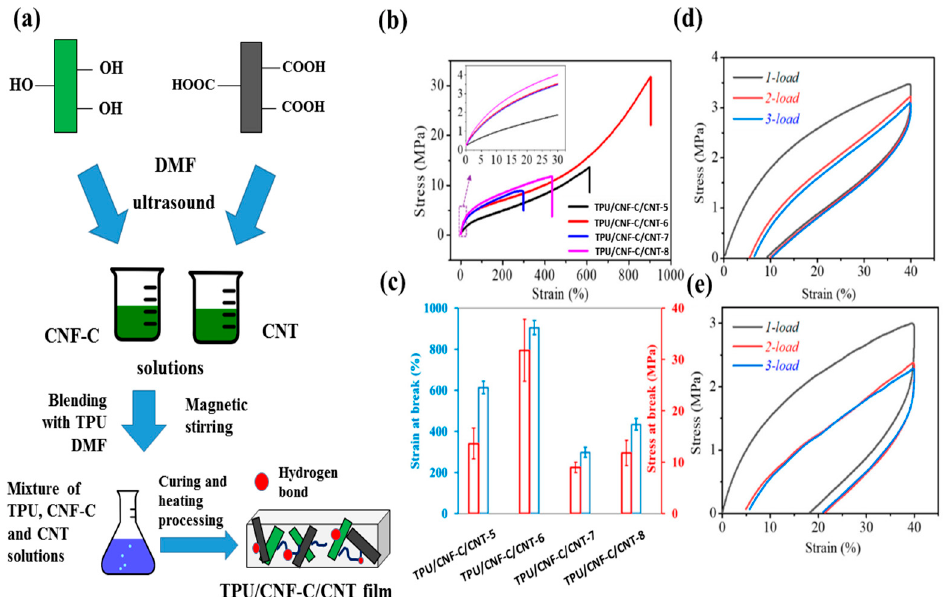
Figure 11. Schematic illustration of the hydrogen bonding interaction mechanism among molecules of TPU, CNF-C, and CNTs and the film formation of TPU/CNF-C/CNTs ( a ), measured mechanical properties of nanocomposite films: typical tensile stress–strain curves, the inset shows the stress– strain curve of each sample stretching up to 30% ( b ), the strain and stress values at break for TPU/CNF-C/CNT composites with different CNT concentrations ( c ), experimental cyclic tensile TPU/CNF-C/CNT composites film without using any stimulus ( d ), and cyclic tensile of TPU/CNF- C/CNT composites fi lm under water stimulus ( e ). Adapted from [25].